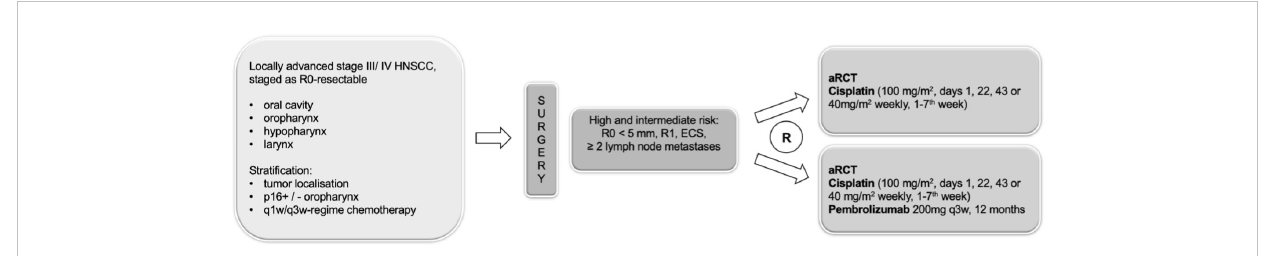
FIGURE 1 Study design of the ADRISK